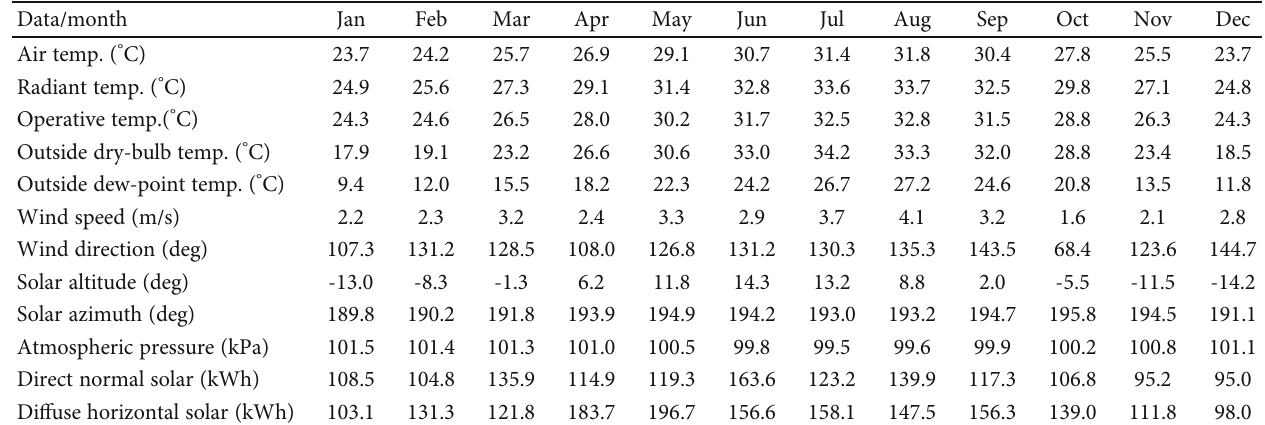
Table 4: Site data and comfort for di ff erent months of a year.